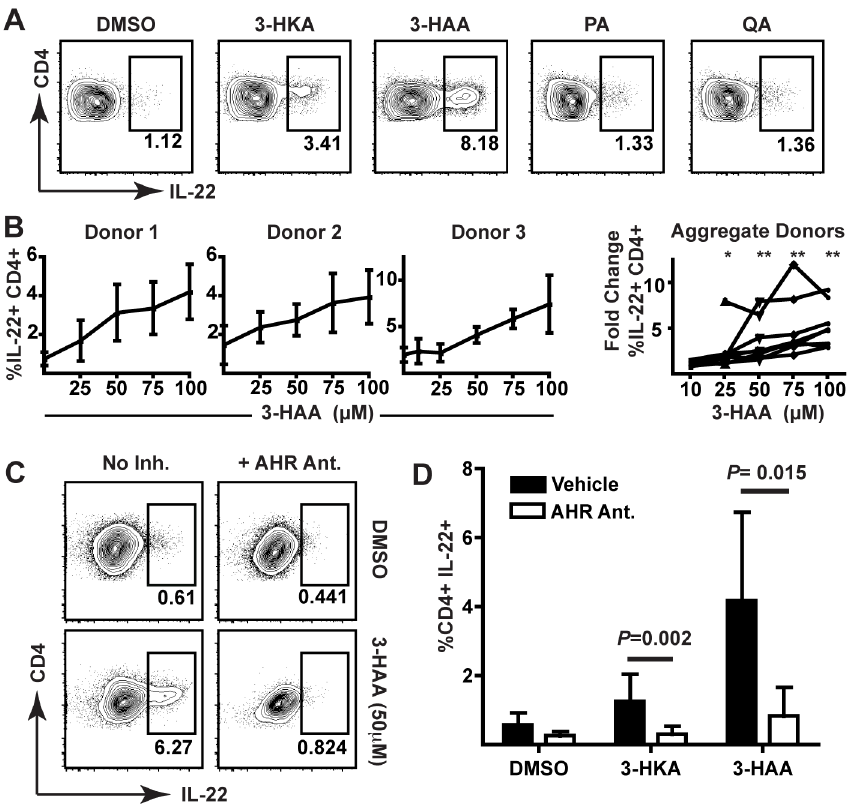
Figure 1. 3-HKA and 3-HAA promote IL-22 expression in stimulated human CD4 + T cells. (A) Flow cytometric analysis of CD4 + T cells following stimulation of human PBMCs in the presence of 100 m M 3-HKA, 3-HAA, PA, or QA for six days. Data represent at least three independent experiments. (B) Flow cytometric analysis of CD4 + T cells from individual and aggregate donors following stimulation of PBMCs in the presence of increasing concentrations of 3-HAA ( m M) for six days. Individual donor data are pooled from at least three independent experiments. Error bars indicate SD. Fold change in IL-22 expression versus vehicle control is statistically different from 1 (Wilcoxon signed rank test; *, p=0.0312; **, p=0.0078; N=8 donors). (C) Flow cytometric analysis of CD4 + T cells following stimulation of human PBMCs in the presence of 3-HAA + / 2 the AHR antagonist, CH-223191. Data are representative of at least three independent experiments. (D) Comparison of IL-22 production in CD4 + T cells following stimulation of human PBMCs in the presence of DMSO, 3-HKA (50 m M), or 3-HAA (50 m M), with or without an AHR antagonist, N=6. P values were calculated by Mann-Whitney. Error bars indicate SD.